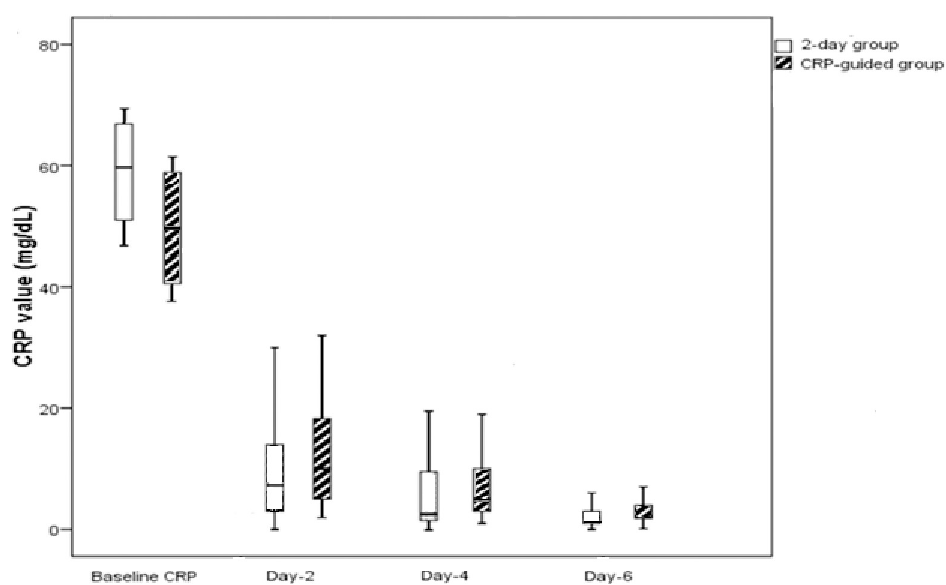
Fig 2. C-reactive protein values at baseline and day 2, 4 and 6. CRP: C-reactive protein. https://doi.org/10.1371/journal.pone.0251716.g002 the two groups over time compared to baseline values; this decrease was comparable between groups (Fig 2).